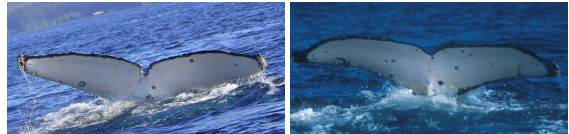
Figure 2. Two samples from the Kaggle Challenge ’Humpback Whale Identification’ showing two different whale individuals.